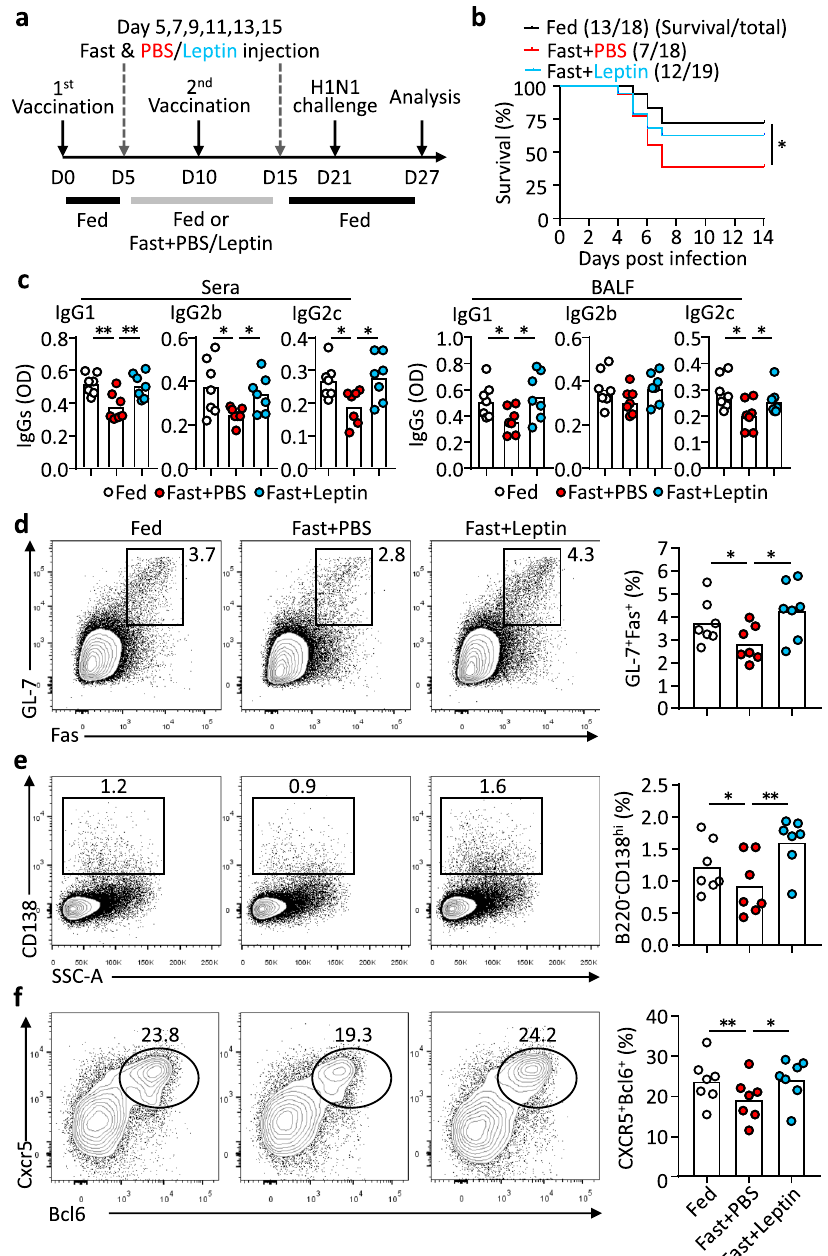
Fig. 7 Fasting impairs vaccination-mediated protection, which can be compensated by leptin replacement. a WT female mice were immunized (s.c.) with human in fl uenza vaccine, following various feeding regimens: normal diet (Fed) ( n = 18, black line), fasting with PBS (Fast + PBS) ( n = 18, red line), fasting with leptin treatment (Fast + leptin) ( n = 19, cyan line); mice were intranasally challenged with H1N1 in fl uenza virus and analysed 6 days post- infection. b Accumulative survival curve of mice after viral challenge (Fast + PBS vs Fed: * P = 0.0369). c ELISA measurement of H1N1-speci fi c IgG1, IgG2b and IgG2c in sera (IgG1: ** P = 0.0073, ** P = 0.0076; IgG2b: * P = 0.0133, * P = 0.0258; IgG2c: * P = 0.0326, * P = 0.0252) and bronchoalveolar lavage fl